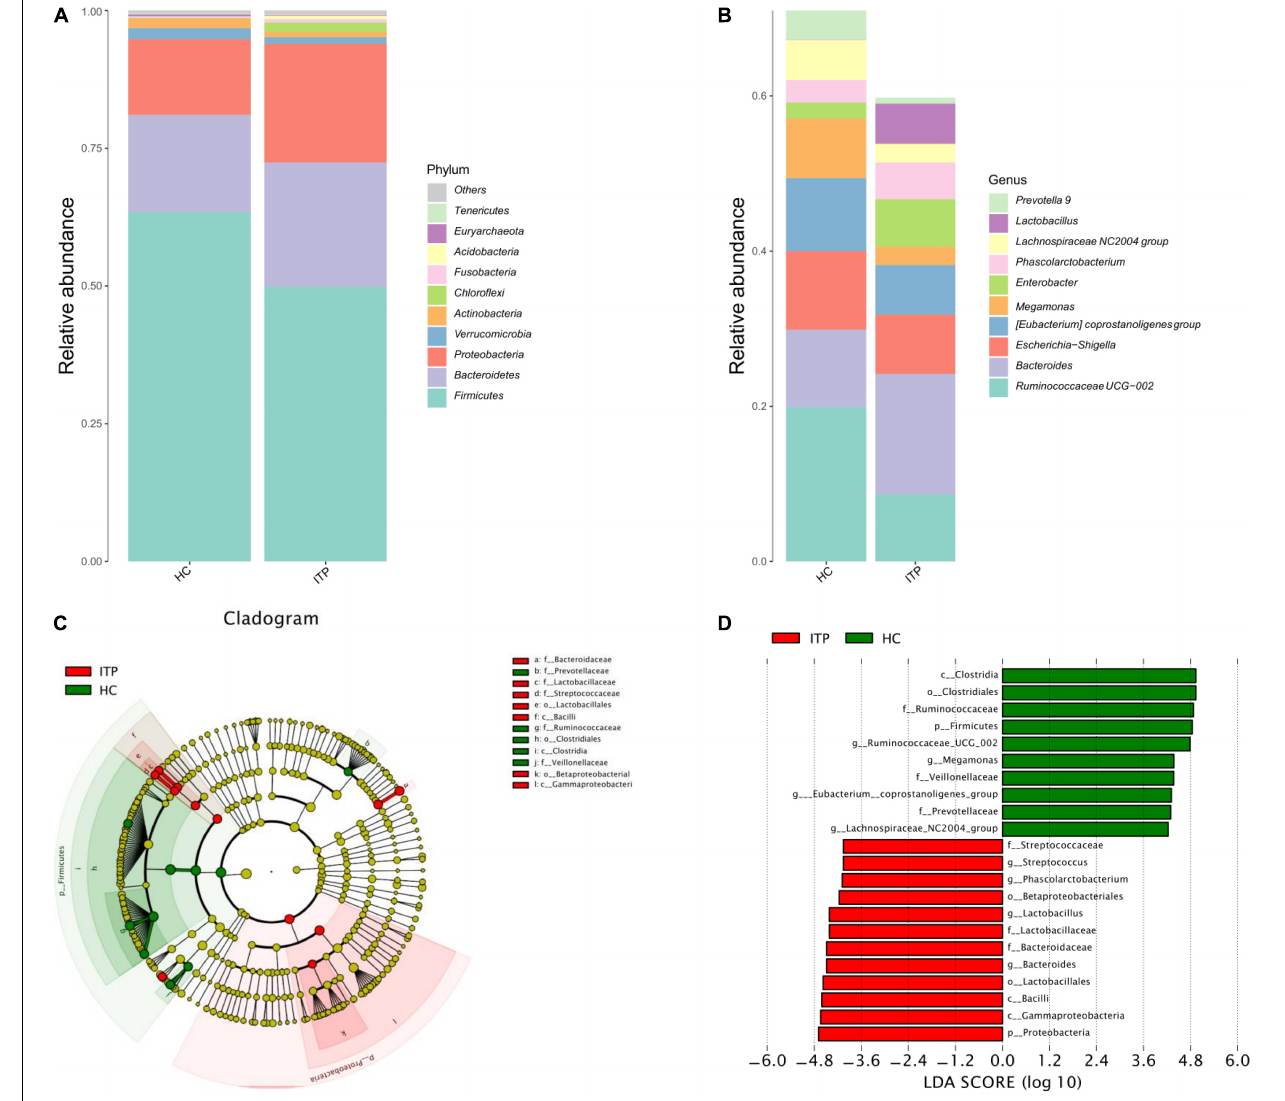
FIGURE 2 | Differences of gut microbiota between ITP patients and healthy controls at phylum and genus level, respectively. (A) Relative abundance of bacterial microbiota in two groups at phylum level. (B) Relative abundance of bacterial microbiota in two groups at genus level. (C) The cladogram is constructed according to the hierarchical structure of classified data. (D) A linear discriminant analysis effect size (LEfSe) between ITP patients (ITP, green) and healthy controls (HC, red) revealed taxonomic abundances between groups (LDA >